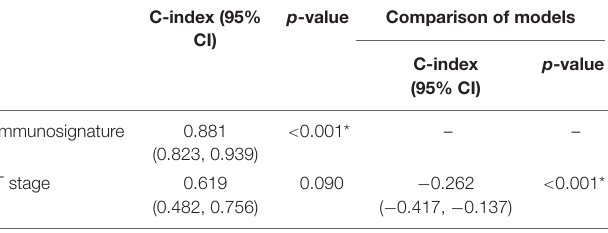
TABLE 1 | The comparison of predictive discrimination ability of the immunosignature and Tumor, Node, Metastasis (TNM) staging